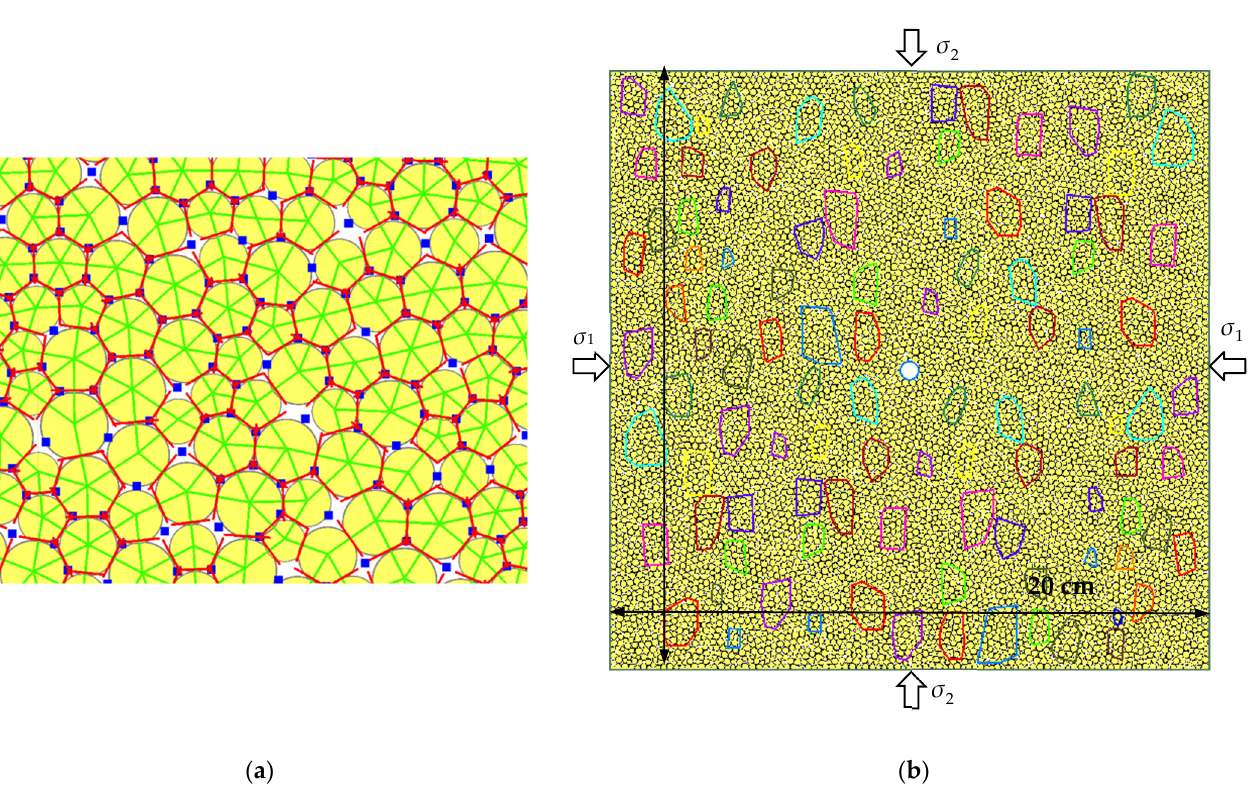
Figure 1. Schematic diagram of fluid and glutenite numerical models. ( a ) Network flow model. ( b ) Boundary conditions.